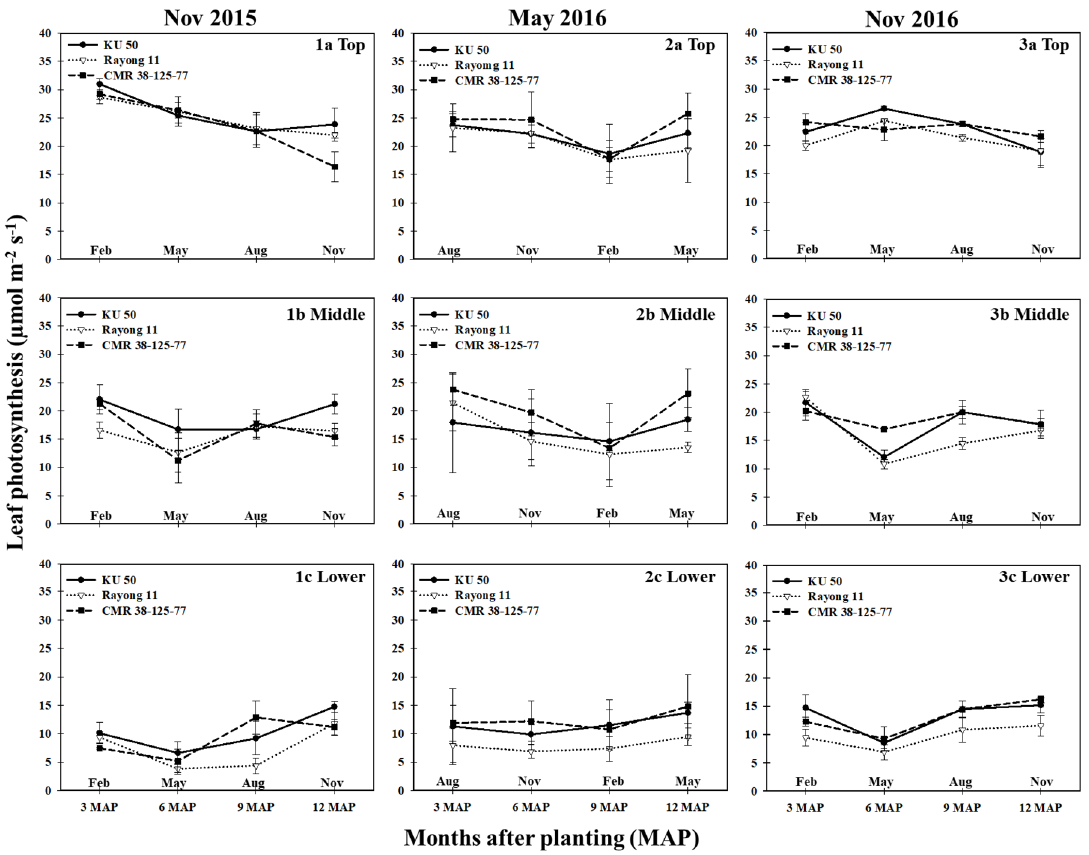
Figure 6. Photosynthesis of the cassava leaves of top ( a ), middle ( b ) and lower ( c ) canopy at 3, 6, 9 and 12 months after planting (MAP) when planted in November 2015 (1) and May (2) and November (3) 2016. The bars indicate the standard deviation of means.